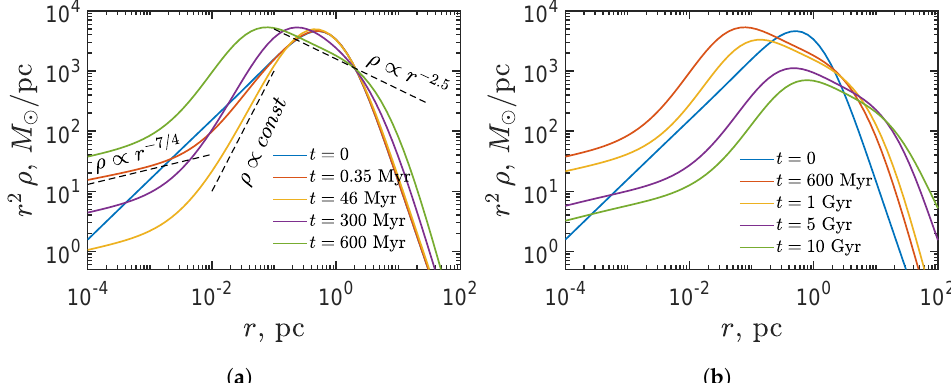
Figure 1. The evolution of the PBHs mass distribution in the cluster before ( a ) and after ( b ) the self-similar expansion phase is shown.